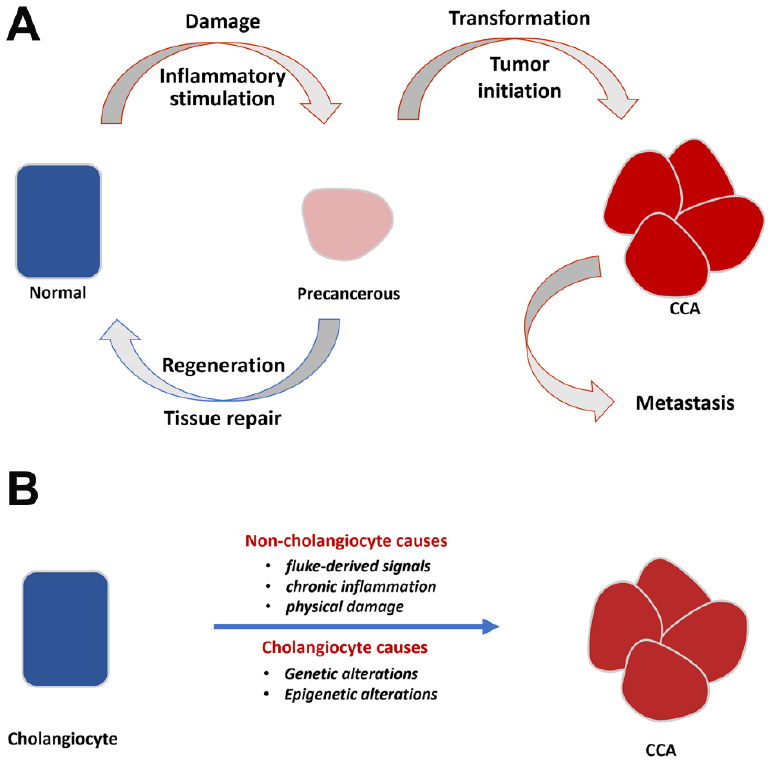
Figure 3. Putative epithelial–mesenchymal transition (EMT)-related factors that influence CCA progression and summary of CCA’s biological causes. ( A ): Putative EMT-related factors. Fluke- derived physical and biochemical stimulation and host inflammatory responses lead to repeated cycles of tissue damage, repair, and regeneration and to cholangiocyte morphological changes dur- ing which EMT regulation may play an importance role. In the course of chronic fluke infection, tumor initiation leads to a breach of the cholangiocyte basement membrane and local and distal metastases, all of which involve modulation of epithelial/mesenchymal characteristics of cholangio- carcinoma cells. ( B ): Summary of biological causes leading to transformation from cholangiocyte to CCA. Cholangiocyte-related causes include genetic and epigenetic alterations either occurring spontaneously or as a consequence of fluke infection. Non-cholangiocyte-related causes include both parasite-induced and host inflammatory response-induced changes to cholangiocytes and their extracellular